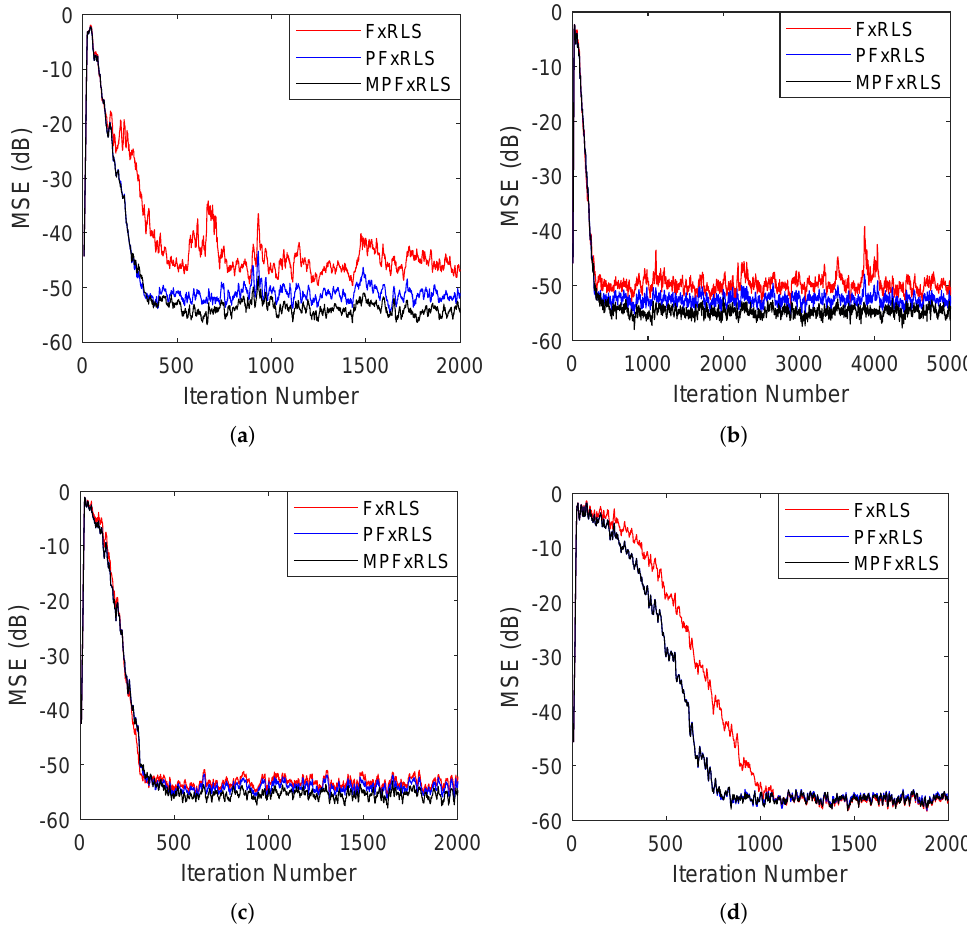
Figure 2. The sensibility evaluation of forgetting factor λ : ( a ) shows the MSE learning curves of λ = 0.90. ( b ) shows the MSE learning curves of λ = 0.93. ( c ) shows the MSE learning curves of λ = 0.96. ( d ) shows the MSE learning curves of λ =